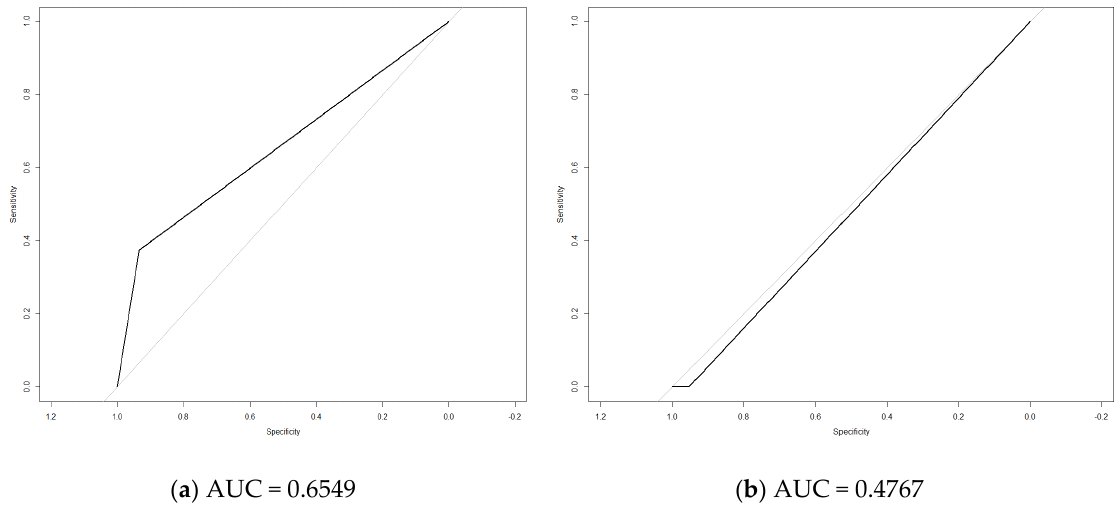
Figure 2. ( a ) Receiver operating characteristic (ROC) curve of dermal electrochemical conductance (DEC) versus electromyography (EMG) as the gold standard in the population with diabetes mellitus. ( b ) ROC curve of DEC versus EMG as the gold standard in the population without glucose disturbances. AUC: Area under the ROC curve.